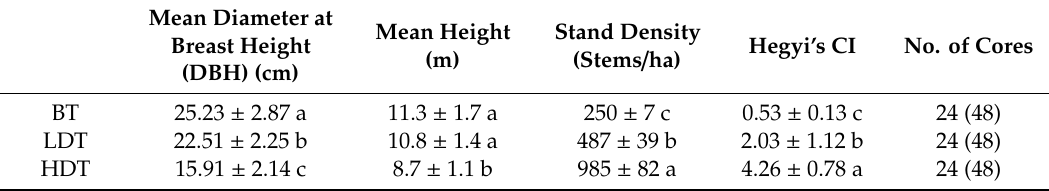
Table 1. Statistical description (mean ± SD) of border trees, low-density, and high-density stands of Mongolian pine at the experimental site in Zhangbei County, Hebei Province, China. Lower-case letters indicate significant di ff erences ( p <